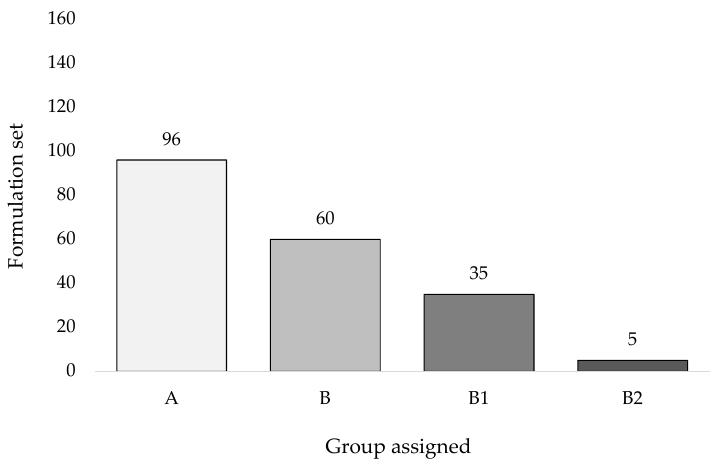
Figure 12. Group classification of photopolymer formulations screened. Group A indicates formulations with PS ≠ 5 ( n = 96); group B reports formulations with a PS = 5 or PS = * at least at one printing resolution ( n = 60); groups B1 ( n = 35) and B2 ( n = 5) list formulations with a PS = 5* at least at one or at each printing resolution used, respectively.